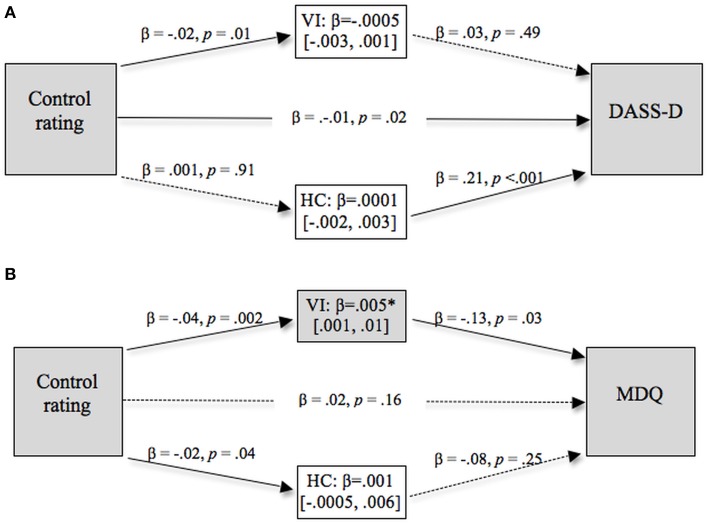
Values as a mediator of the relationship between judgment of control and measures of (A) depression and (B) bi-polar symptoms, controlling for anxiety. Significant direct pathways are indicated by solid (vs. broken) lines. Significant indirect pathways are emphasized with gray shading. Ninety-five percentage confidence limits around the indirect effects are shown in brackets.